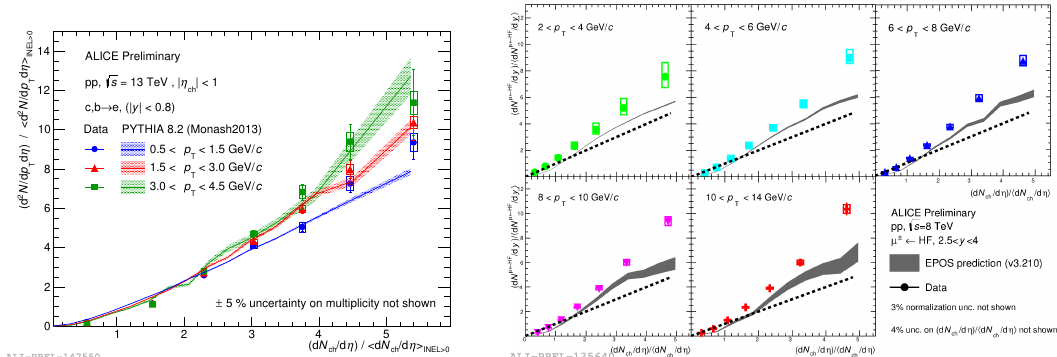
(d1 2 INEL>0 > η /d ch N ) / <d η /d ch N Figure 2: Self-normalized yields of heavy-flavor hadron decay electrons measured (cid:112) s = 13 TeV (left) and muons measured in pp collisions at in pp collisions at 8 TeV (right) as a function of charged-particle multiplicity. The measurements are compared to model predictions from PYTHIA8 and EPOS3 [ 2,4 ]